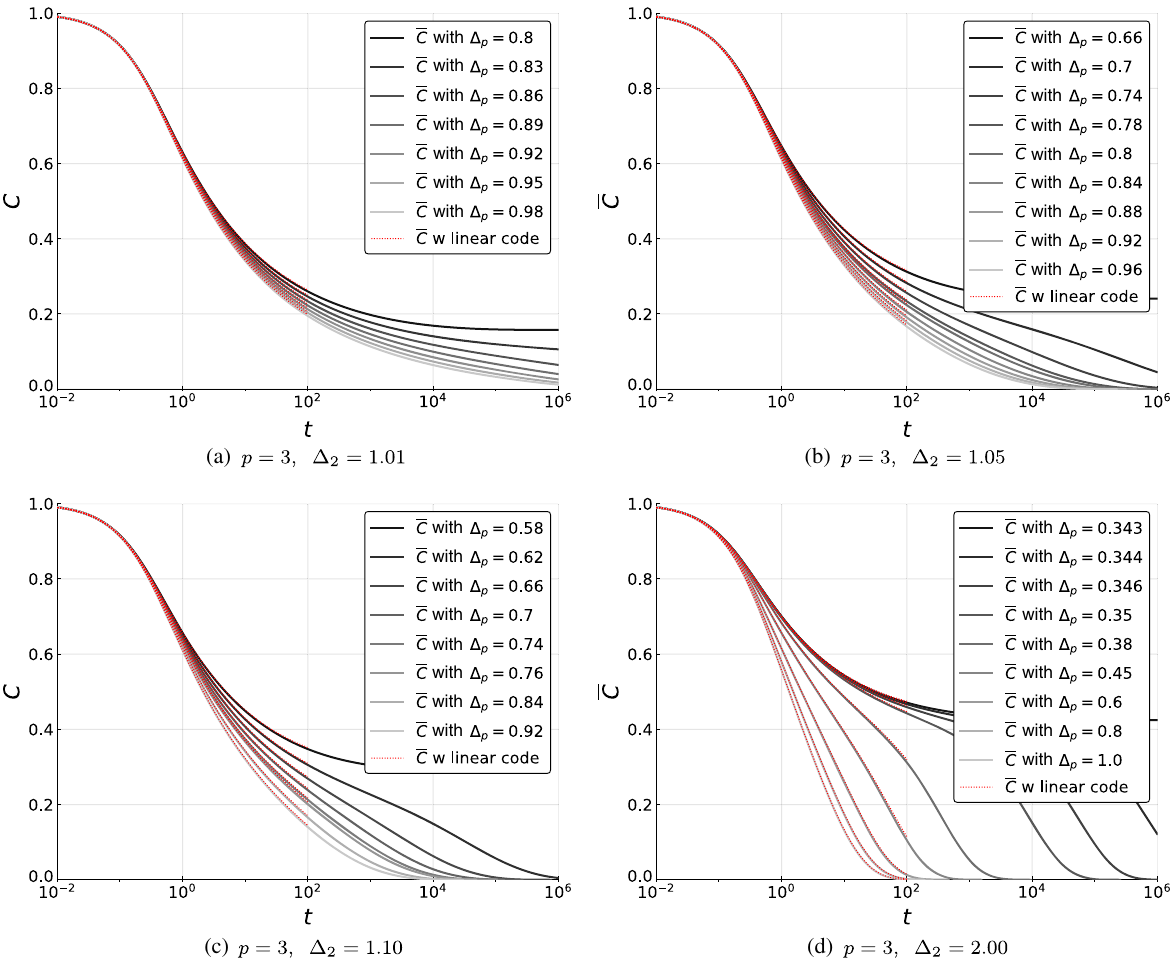
¯ C 0 ¼ 1 . 0 at fixed Δ 2 for different Δ . The dotted red p